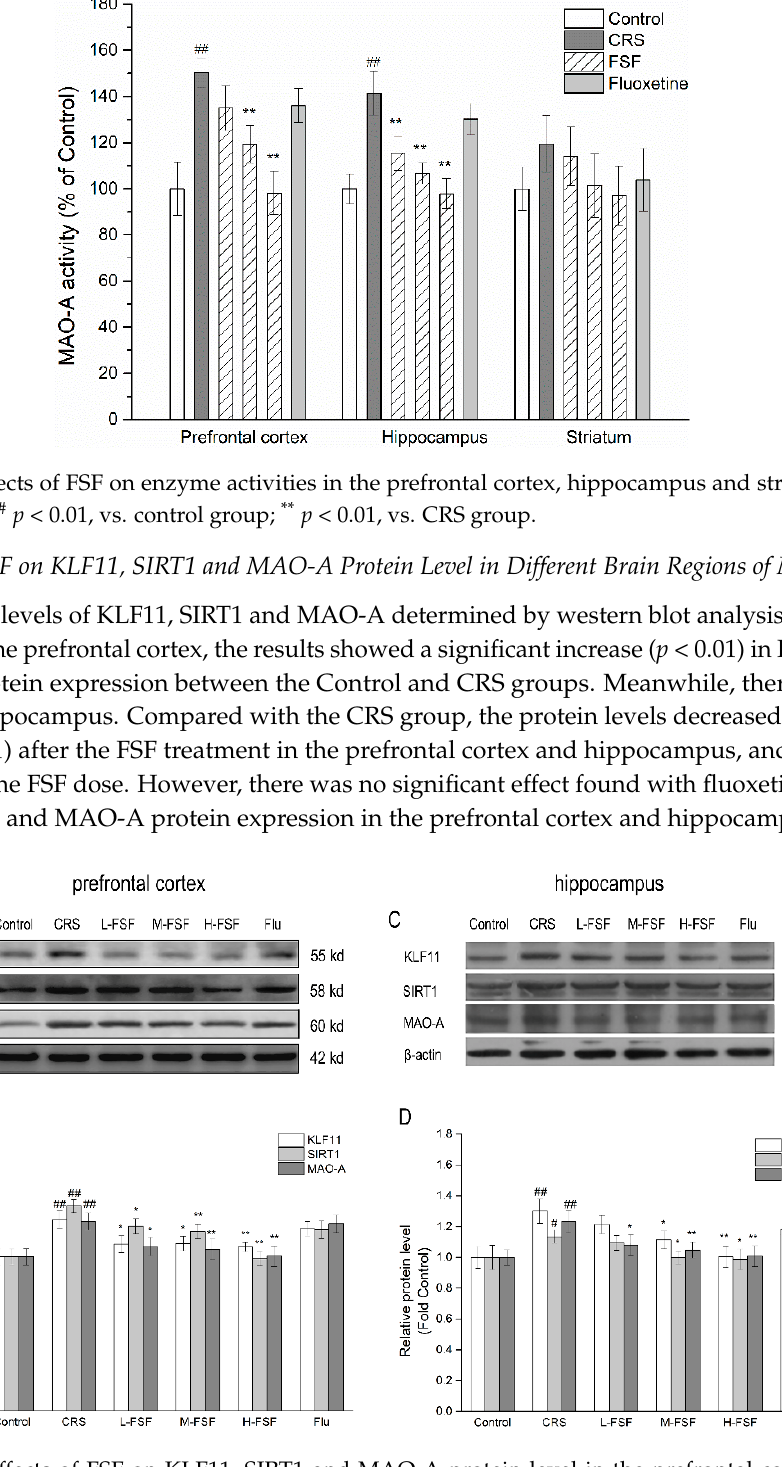
Figure 10. Effects of FSF on KLF11, SIRT1 and MAO-A protein level in the prefrontal cortex and hippocampus in mice. ( A ) Representative bands of protein in the prefrontal cortex. ( B ) The relative protein level in the prefrontal cortex. ( C ) Representative bands of protein in the hippocampus. ( D ) The relative protein level in the hippocampus. # p < 0.05, ## p < 0.01, vs. control group; * p < 0.05, ** p < 0.01, vs. CRS group.